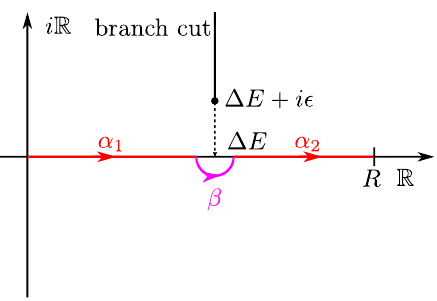
Figure 11 . Contour used to compute the vacuum part. Black dot: the pole of the function G (cid:15) ; (cid:11) 1 , (cid:11) 2 : paths on the real line; (cid:12) : path in the complex plane (half circle) avoiding the singularities of G (cid:15)